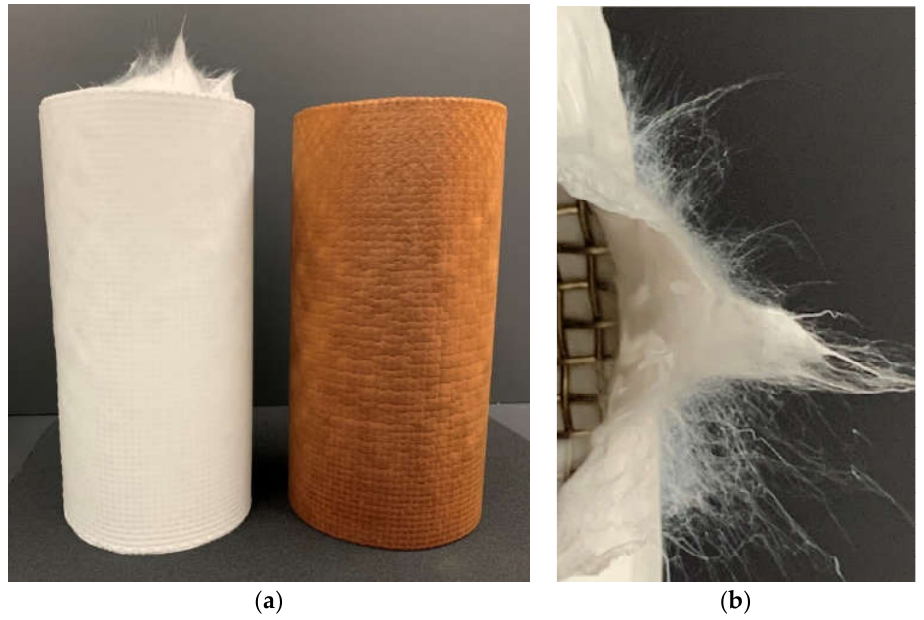
Figure 9. Comparison of as-spun media with stabilized media. ( a ) Side-by-side comparison for trial #6 (as-spun) and trial #5 (after stabilization). ( b ) Close up view of as-spun polyacrylonitrile fibers.